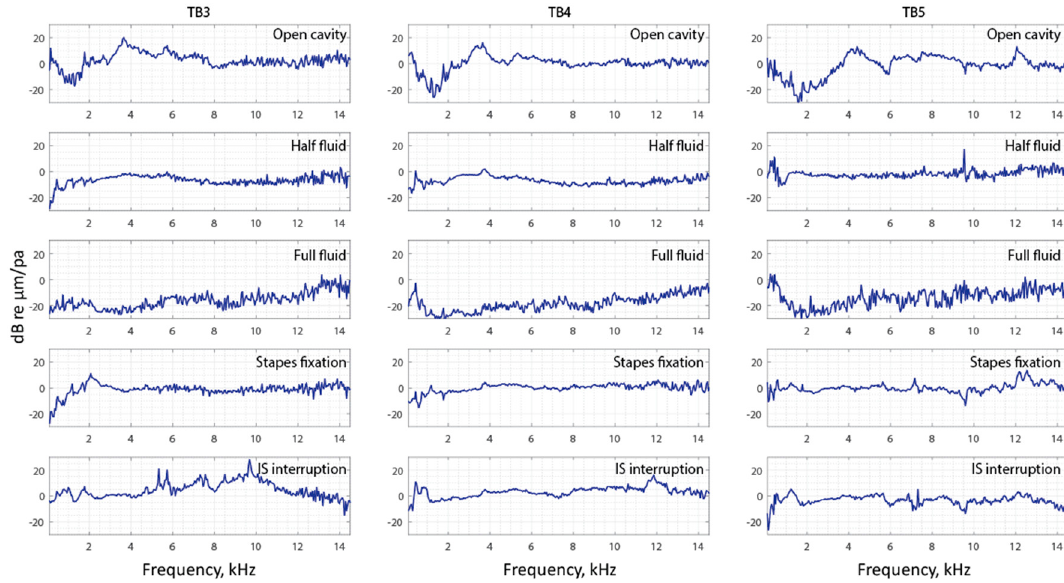
Figure 12. The complex model indicator function subtracted by the closed cavity case of TB3–5.